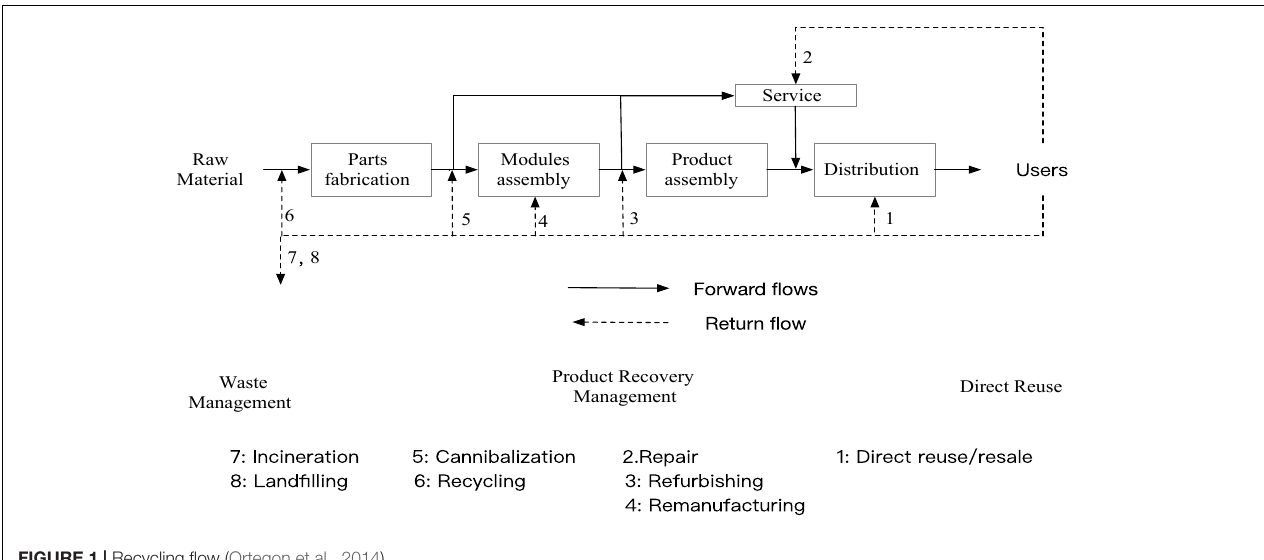
FIGURE 1 | Recycling flow (Ortegon et al.,